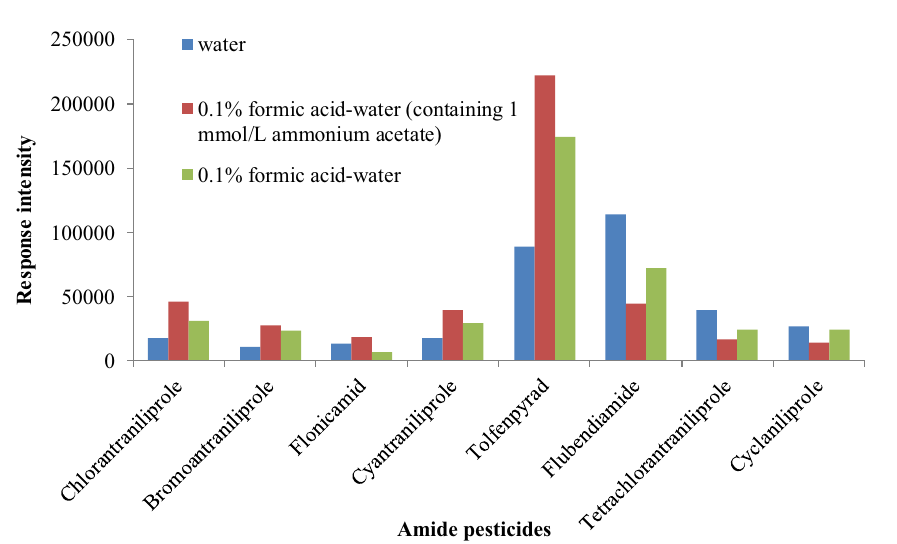
Figure 3. Response intensity of amide pesticides in different mobile